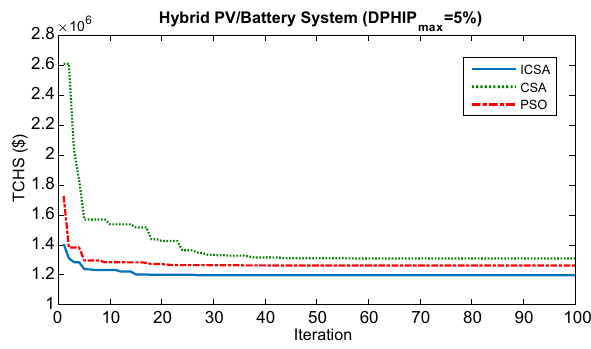
Fig. 4 Convergence curve of different algorithms in PV/Batt system designing with DPHIPmax = 5% considering